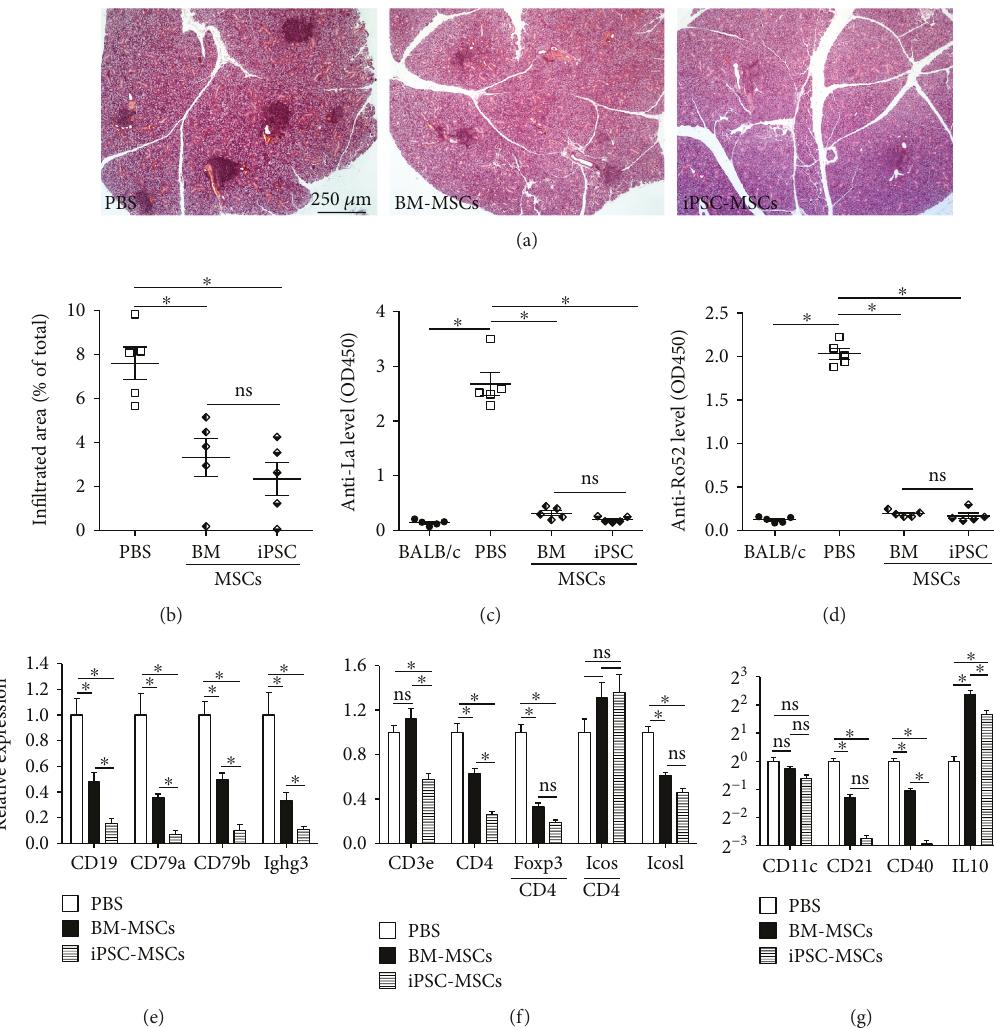
Figure 1: E ff ects of iPSC-MSC on preventing the onset of sialadenitis in NOD mice. (a) H&E staining of SMG sections. (b) Relative area of lymphocytic in fi ltrates in SMGs. (c, d) Serum level of autoantibodies determined by ELISA. Expression of genes related to B cells (e), T cells (f), and APCs (g) in SMGs determined by qRT-PCR. n = 5 ; ∗ P < 0 05 ; ns: not signi fi